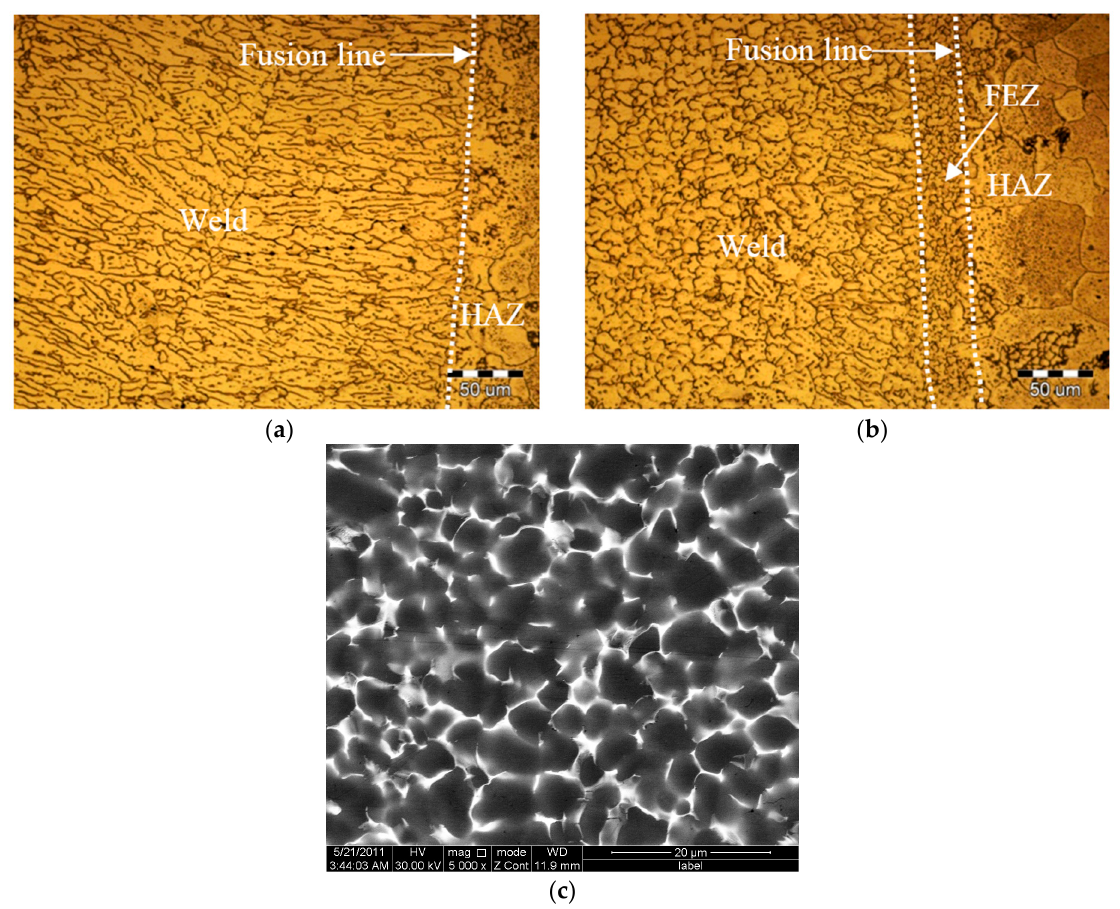
Figure 7. Microstructure of ( a ) autogenous laser welding; ( b ) PCALW; and ( c ) a SEM image of the FEZ.